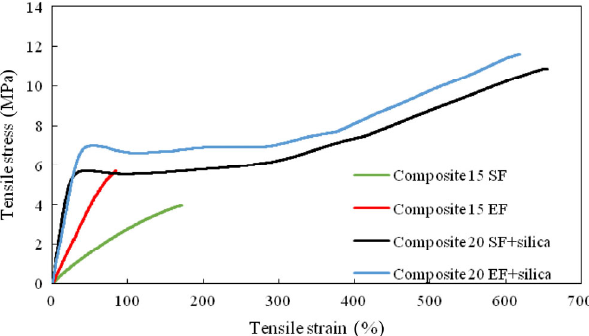
Fig. 1 Stress–strain relations of all composites with randomly oriented fibers.